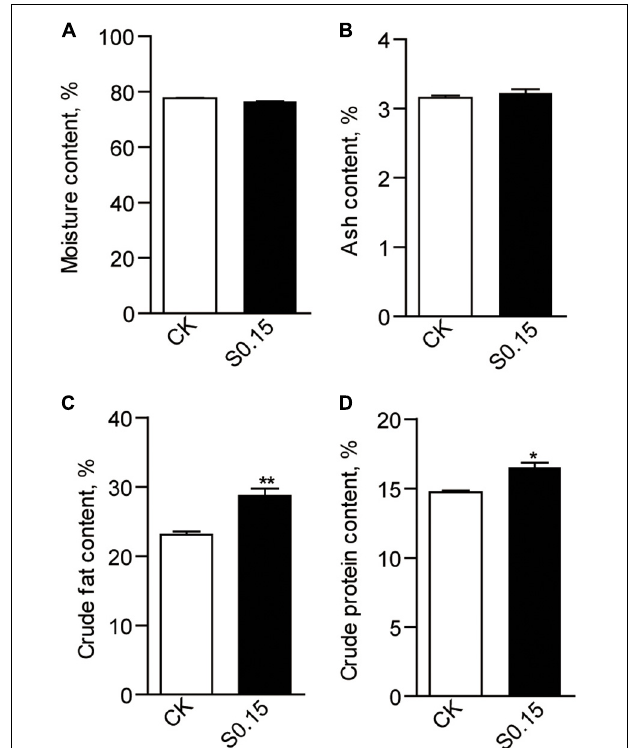
FIGURE 2 | Whole body composition in zebrafish fed the CK or S0.15 diet for 4 weeks. (A) Whole body moisture, (B) whole body ash, (C) whole body crude fat, and (D) whole body crude protein. Values are means ± SEMs ( n = 3 biological replicates). * p < 0.05, ** p < 0.01. CK, control-check diet; S0.15, 0.15% succinate-supplemented